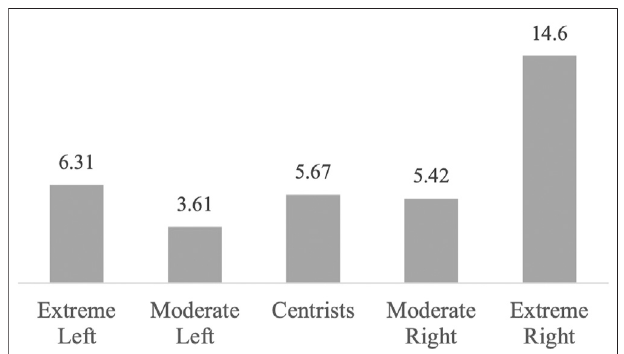
FIGURE 6 | Percentage Welfare Chauvinists Who State that Immigrants ShouldNeverbeGrantedSocialrightsbyPoliticalIdeology.Source:European Social Survey, cumulative dataset, waves 4 and 8 (N: 41,618). Own